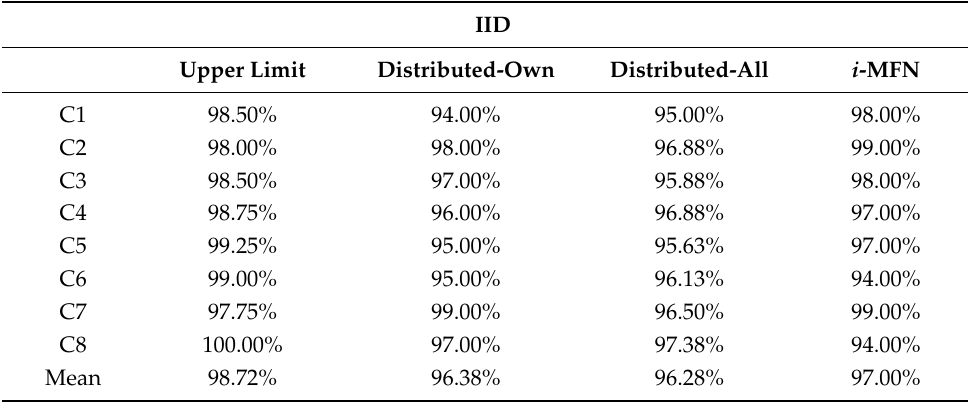
Table 4. Comparison of diagnostic accuracy under IID